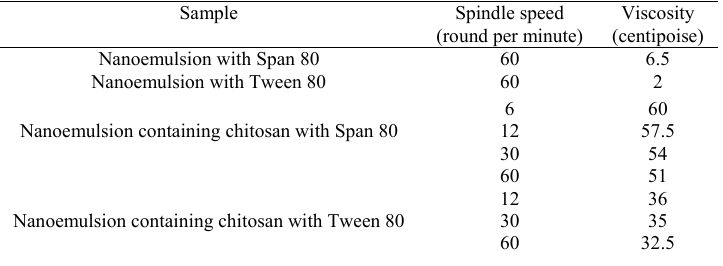
Table 3. Rheological properties of